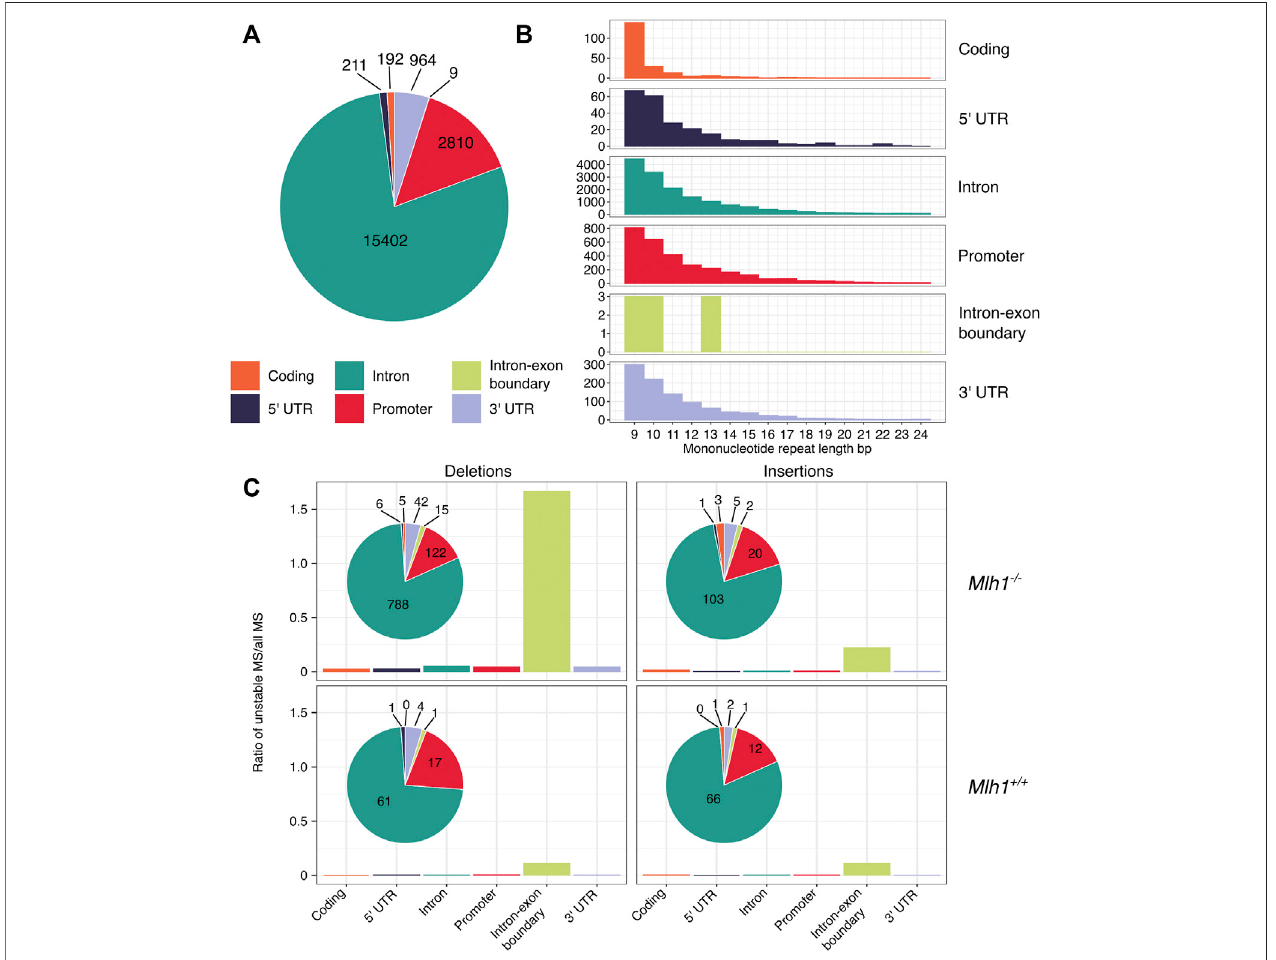
FIGURE 3 | Deletions are enriched in mononucleotide repeats that are located within intron-exon boundaries. (A) Mononucleotide repeats in different genic regions. Exome-wide, the majority of mononucleotide repeats are located within intronic sequences. (B) Number of different-sized mononucleotide repeats in different genic regions. Coding sequences have relatively more short repeats when compared to other genic regions. (C) Indels in mononucleotide repeats within different genic regions.Deletionsinmononucleotide repeatsareenriched inexon-intron boundaries in Mlh1 − / − cells,but notin Mlh1 +/+ cells.Insertionsinmononucleotiderepeats are not enriched in any particular genic region in Mlh1 − / − or Mlh1 +/+